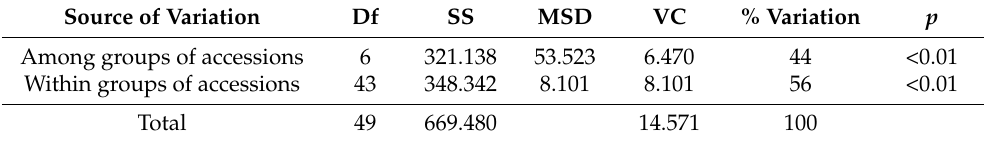
Table 7. Analysis of the molecular variance (AMOVA) for the accessions of C. intybus . Source of Variation Df SS MSD VC % Variation p Among groups of accessions 6 321.138 53.523 <0.01